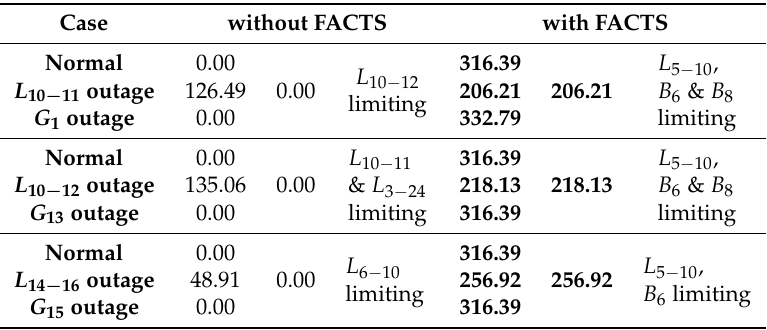
Table 3. TTC values from area 1 to area 2 for IEEE 24 bus system.